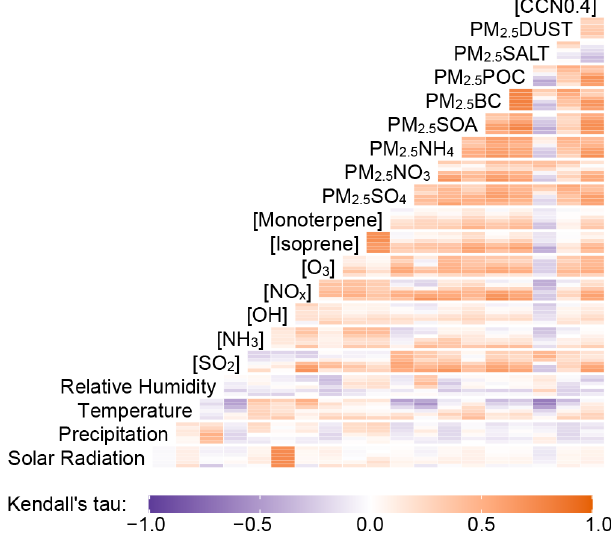
Figure 7. Kendall rank correlation ( τ ) for the 19 predictors and [CCN0.4] in the RFRM training dataset ( ≈ 101 million rows). The boxes show corresponding τ value according to color scale. Boxes are divided vertically to represent τ for each selected model height: surface, ≈ 1, ≈ 2, ≈ 4, ≈ 6, and ≈